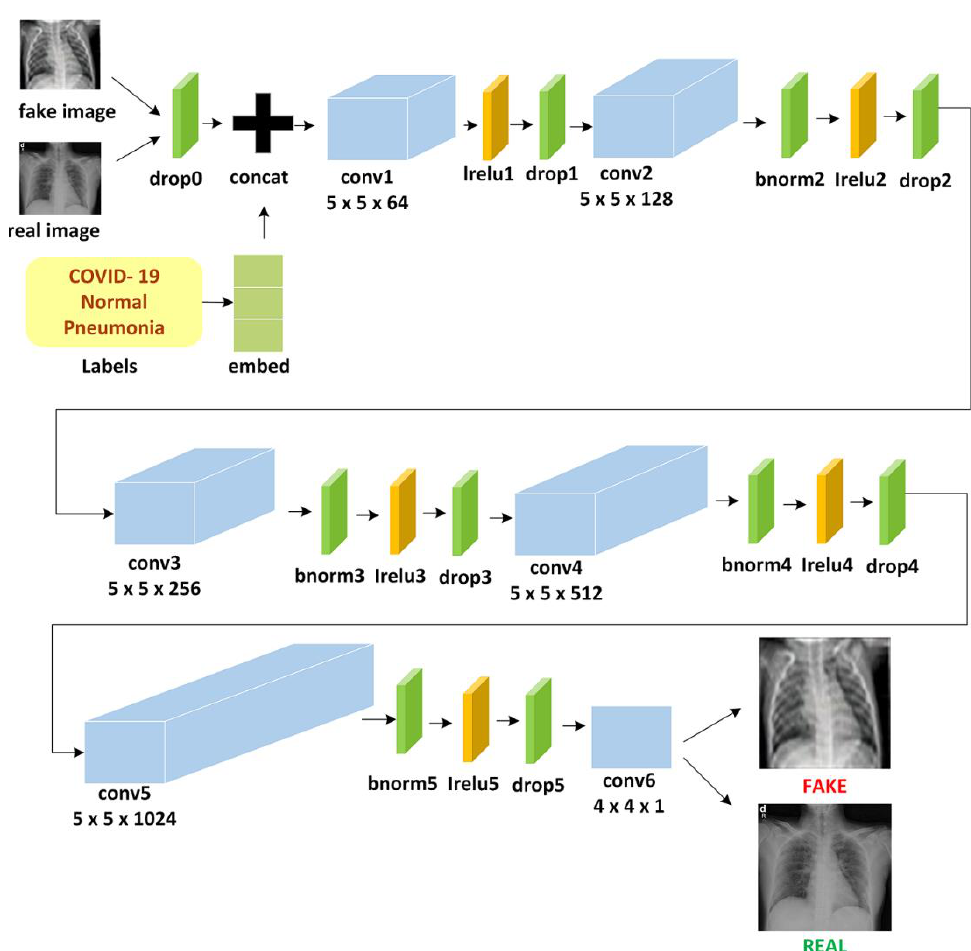
Figure 5. The proposed architecture of the CGAN discriminator. The discriminator learns from real images as well as image labels and down-samples the images produced by the generator using six convolutional layers to obtain the classification. Table 2. Parameter configuration of the CGAN network.